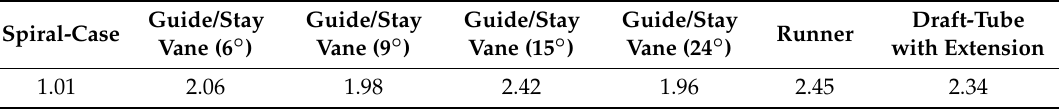
Figure 2. Computational domain and mesh. ( a ) Geometry; ( b ) mesh. Table 2. Number of mesh elements (million).